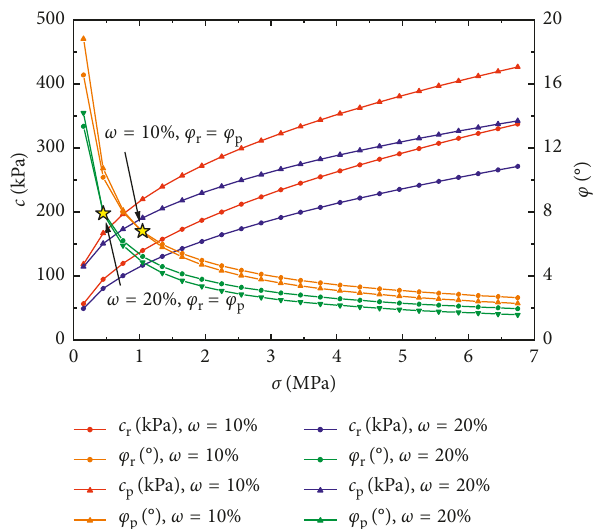
Figure 15: Curves of shear strength parameters (red fault gouge).